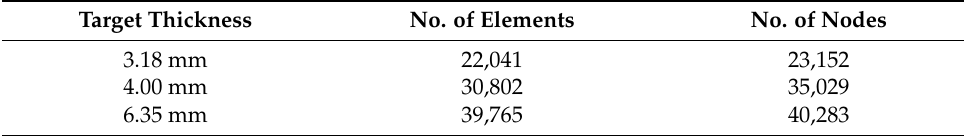
Table 5. Details of no. of elements and nodes for the FE